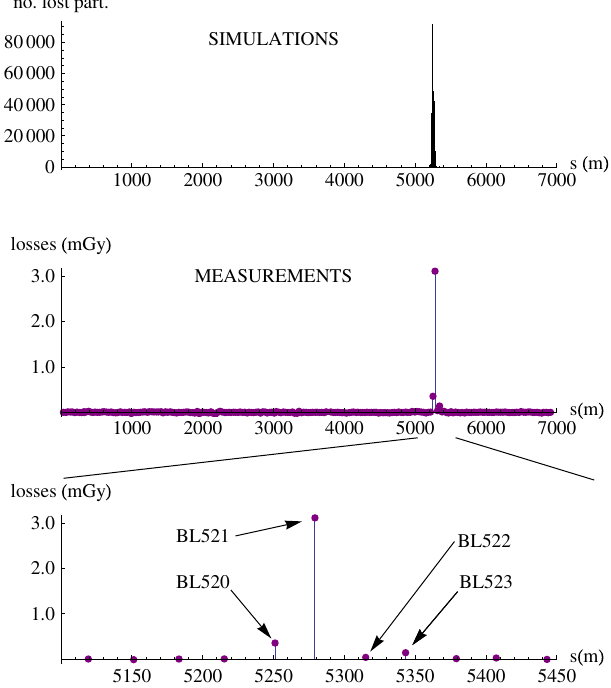
FIG. 12. (Color) Example of simulated ICOSIM (top) and mea- sured (middle) loss map of the whole SPS ring with a 106 : 4 GeV = nucleon circulating 208 Pb 82 þ beam. The bottom part shows a close-up of the loss peak in the measurements, with the names of the BLMs with the highest signals indicated. The simulated losses were binned in 5 m intervals. The colli- mator is located at s ¼ 5222 m , just upstream of the large loss peak.